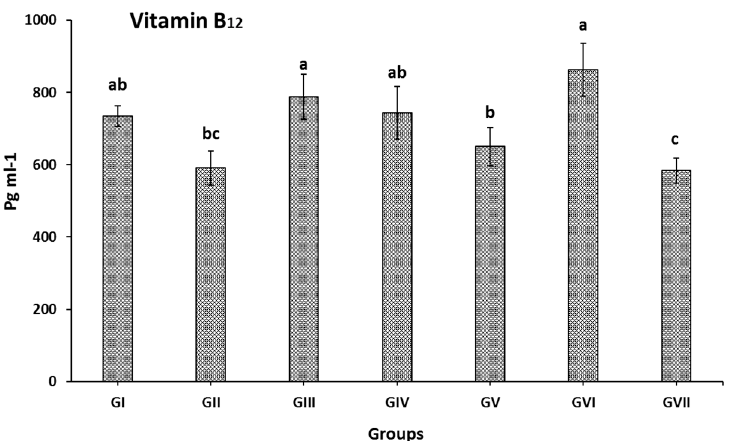
Figure 2. Plasma vit. B 12 levels (pg mL − 1 ) of indomethacin-induced gastric ulcer in rats: GI: negative control; GII: positive ulcer control; GIII: ulcer+ SP; GIV: Ulcer+ KF; GV: ulcer+ KP; GVI: ulcer+ SP, KF, KP; GVII: ulcer+Lansoprazole (references group). Table 4. Effect of SP, KF, KP, and SFP extracts on blood iron and Hb concentrations of indometha- cin-induced gastric ulcer in rats (mean ± SE), n = 6.